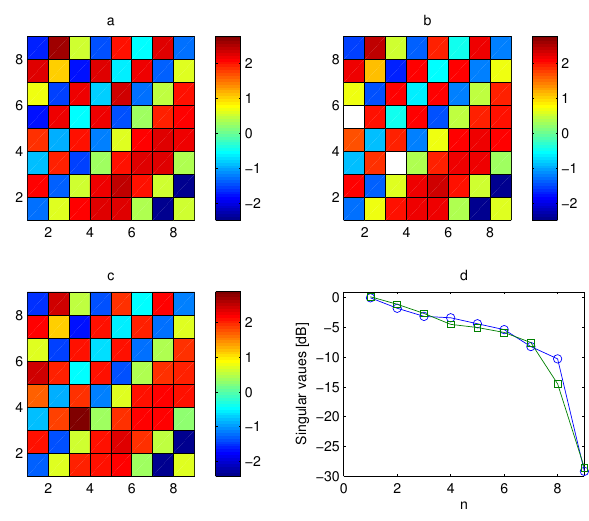
Figure 8. 9 × 9 MIMO system in a corridor, in phase of the channel matrix; ( a ) exact (noise-free); ( b ) measured; ( c ) estimated; ( d ) singular value of the exact (circles) and estimated (squares) matrices; the geometry of the problem is shown in Figure 7d.